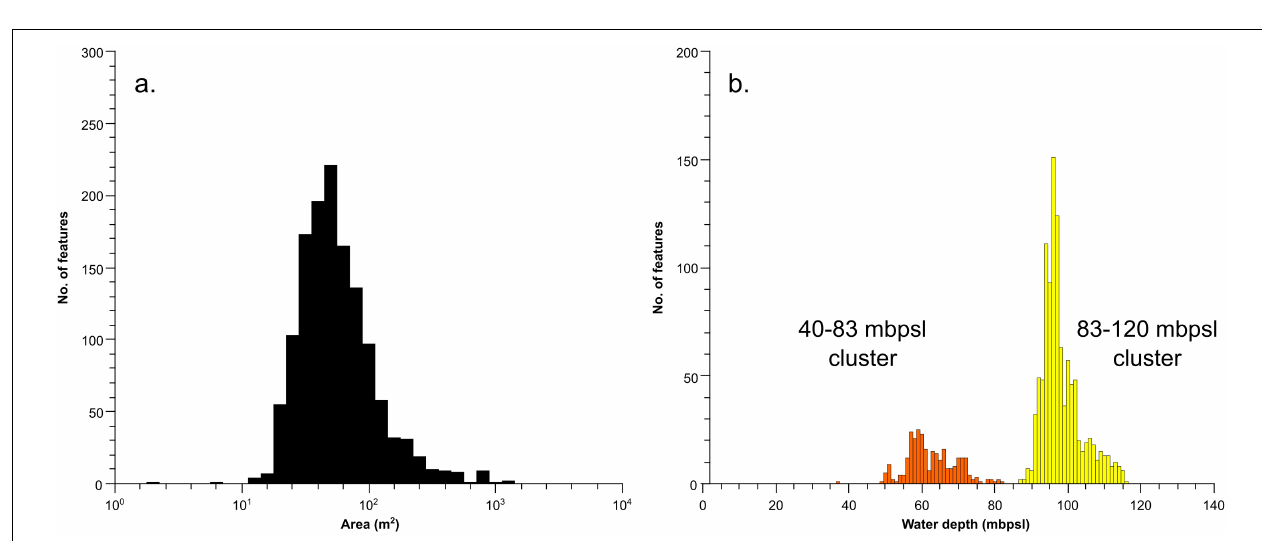
FIGURE 2 | (A) Output of automated mapping showing the locations of the mounds. (B) Density map with 1,000 m search radius highlighting areas of high mound density and locations of spoil grounds.